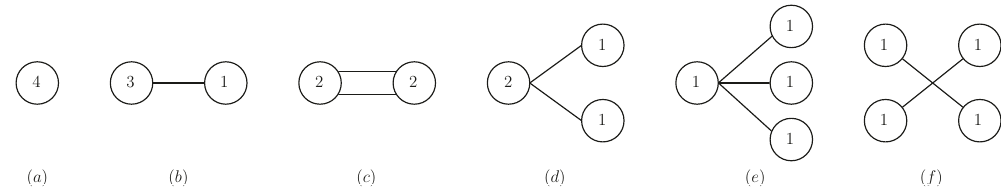
Figure 1 . LO topologies for each of the (cid:12)ve di(cid:11)erent connected contributions of the fourth-order cumulant in (3.1). Following the notation in [30], (cid:18) -induced vertices are denoted by its number of derivatives with respect to (cid:18) applied to the e(cid:11)ective Lagrangian L e(cid:11) . Note that we only refer to